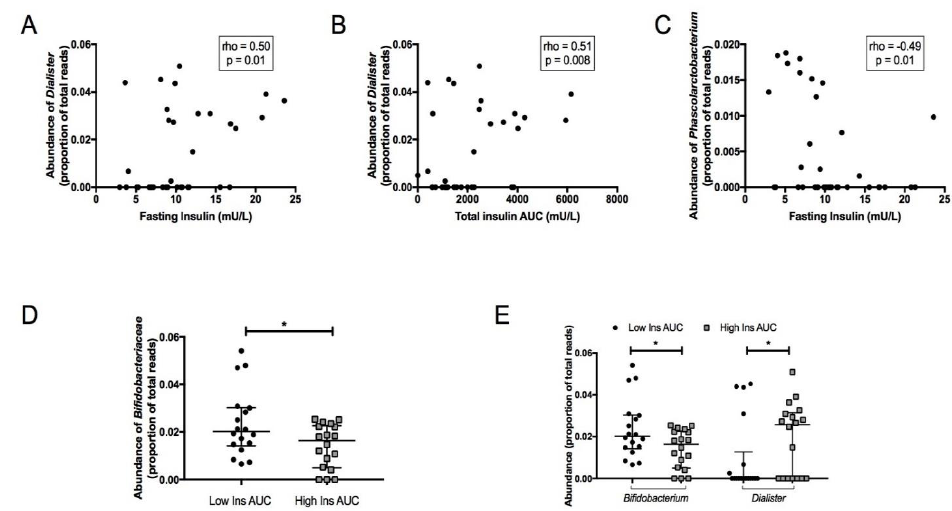
Figure 3. ( A ) The Spearman correlation between fasting insulin and Dialister . ( B ) Spearman correlation between total insulin AUC and Dialister . ( C ) Spearman correlation between fasting insulin and Phascolarctobacterium . ( D,E ) Differences in faecal microbiota between higher and lower insulin secretion groups at family ( D ) and genus ( E ) levels. Boxes represent the interquartile ranges for relative abundances, lines inside the boxes show medians. * p -value < 0.05, ** p -value < 0.01.